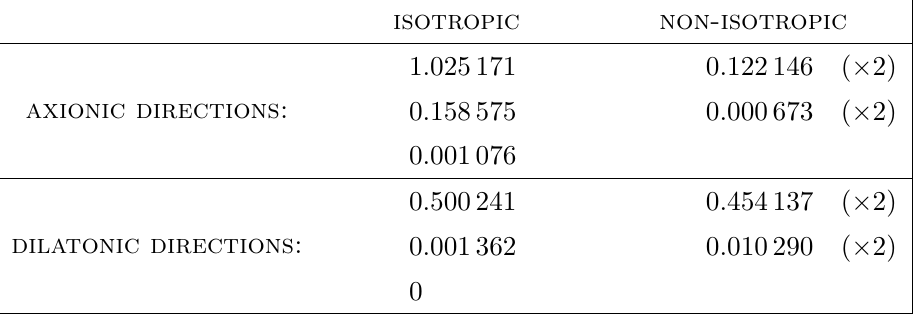
Table 4 . The complete (non-isotropic) physical mass spectrum for our (cid:13)at Minkowski solution in table 3. The numerical values are calculated as the eigenvalues of eigenvalues with double multiplicity correspond to the non-isotropic modes, while the only exactly (cid:13)at direction represents the overall internal